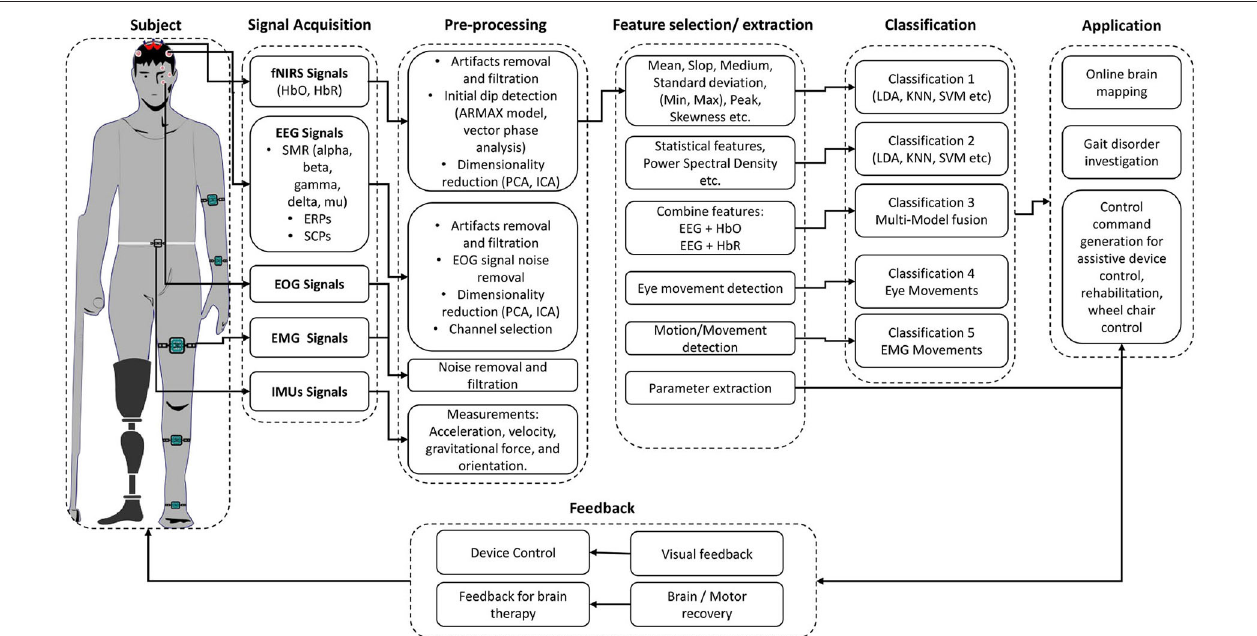
FIGURE 1 | Hybrid BCI system block diagram for gait